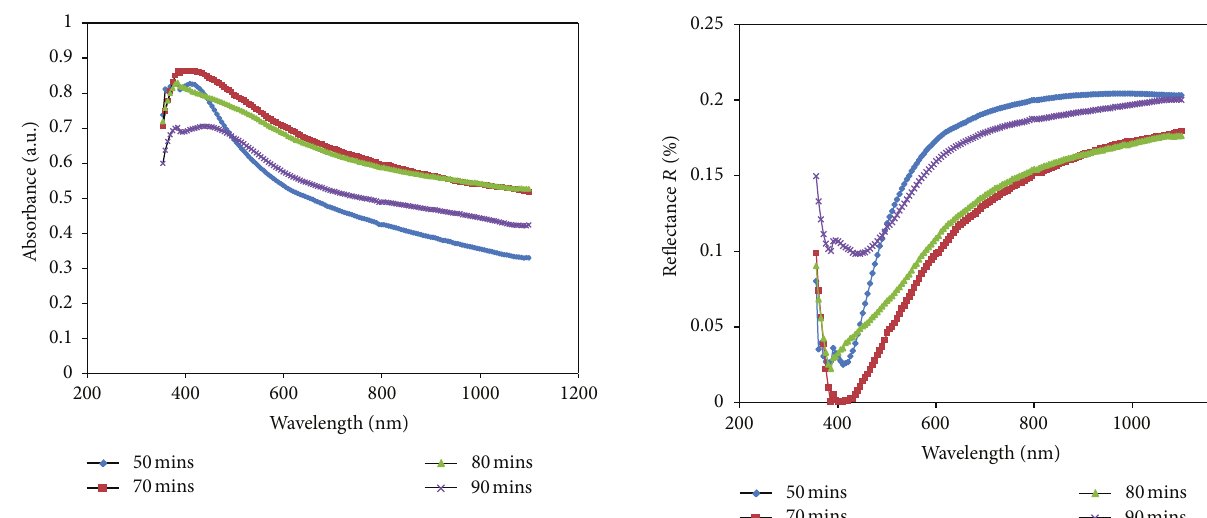
Figure 4: Absorption spectrum of the films.